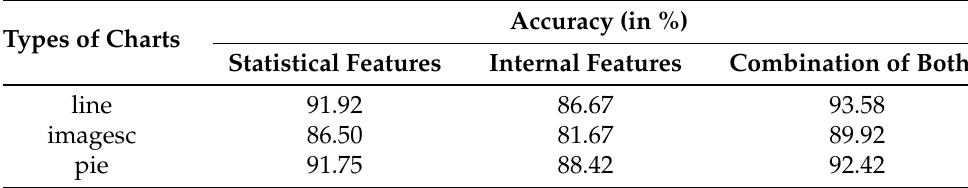
Table 5. Results obtained for three charts using three feature sets.